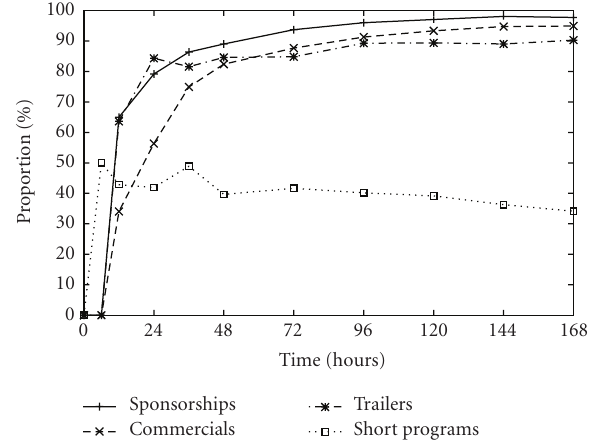
Figure 10: Proportion of repeated segments by categories in TVTrain with respect to the accumulated hours of TV stream.